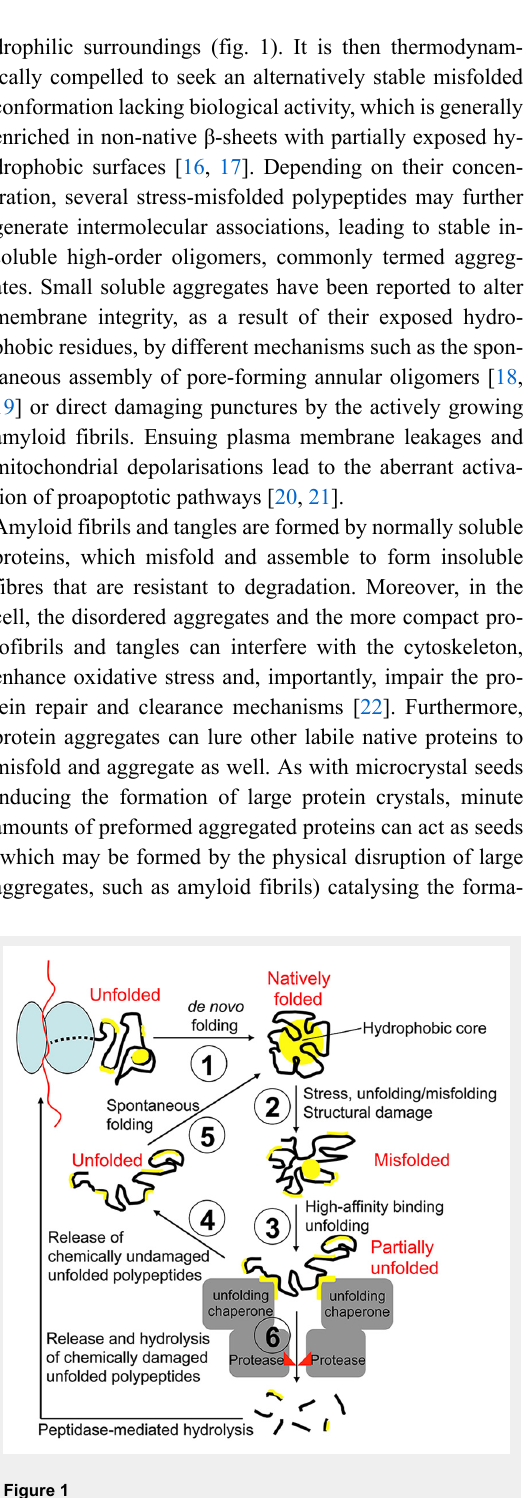
Proteins have an eventful life between birth on the ribosome and death by degradation . Nascent polypeptides with exposed hydrophobic residues (yellow) may spontaneously fold to the native state (step 1) with most hydrophobic residues forming a stable hydrophobic core. Stresses may cause their partial unfolding and misfolding with exposed hydrophobic residues (step 2) that can specifically bind (step 3) the hydrophobic surfaces (yellow) on unfolding chaperones (deep grey) and unfold. Following